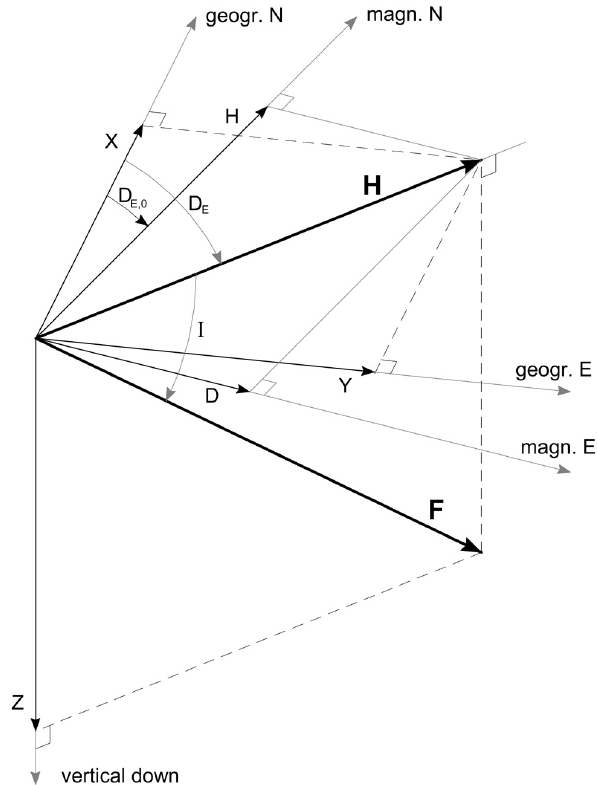
Fig. 1*. Basic resolution of a magnetic field vector, F , in its hori- zontal vector component, H , and its components ( X,Y,Z ) in a ge- ographic and ( H,D,Z ) in a magnetic coordinate system (figure ap- plies to Northern